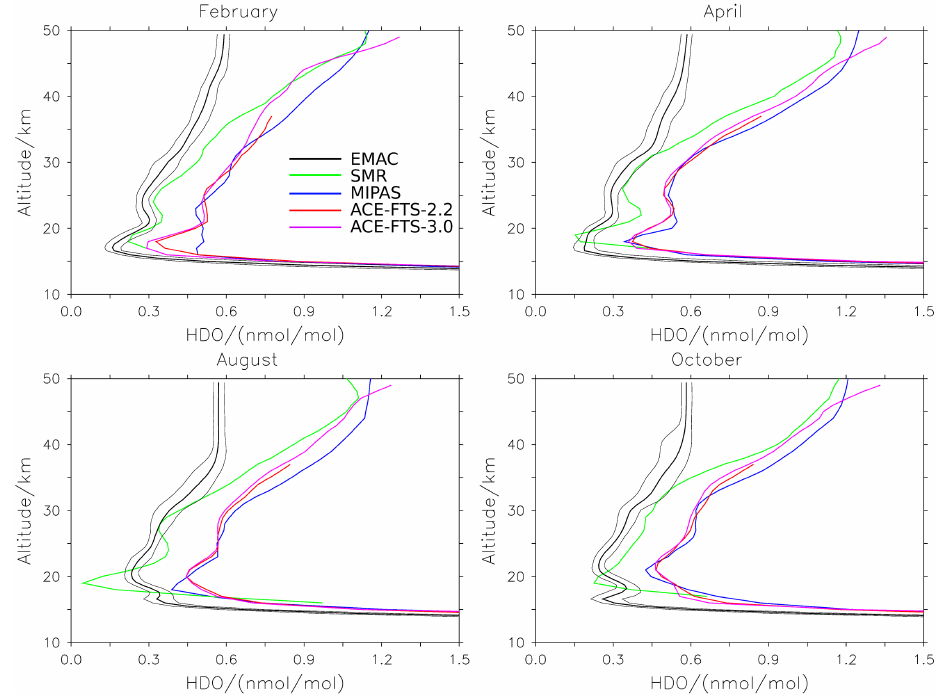
Figure 4. Comparison of HDO mixing ratio–altitude profiles between EMAC and various satellite observations. Black: averages, minima and maxima of 21 monthly averages of the EMAC simulation for the respective months; green: Odin/SMR; blue: ENVISAT/MIPAS; red: SCISAT/ACE-FTS-2.2; purple: